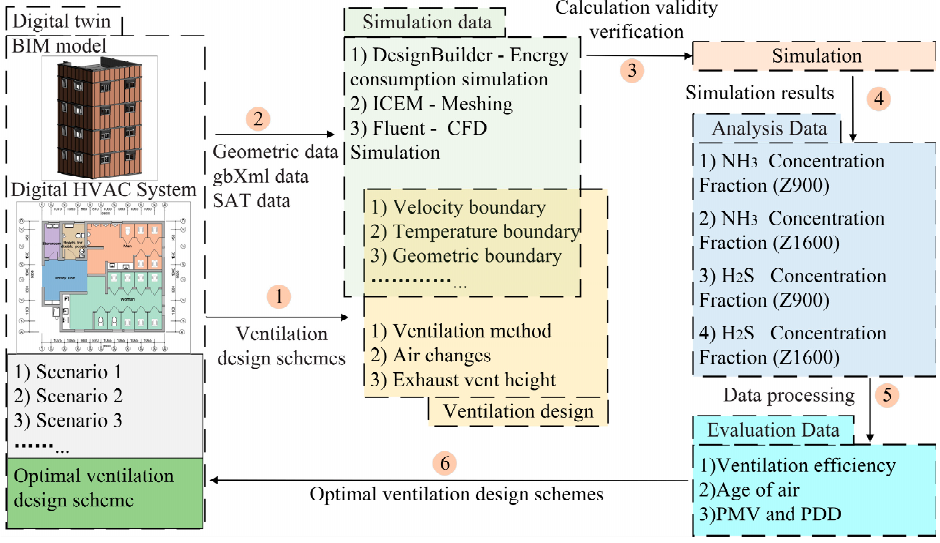
Figure 1. Digital twin evaluation method framework.